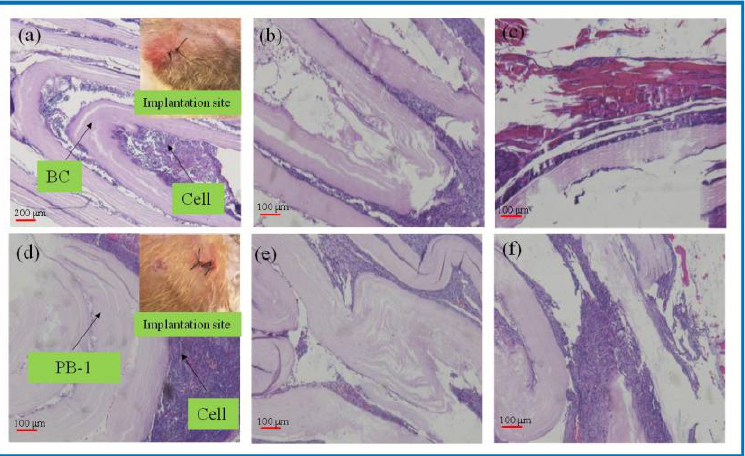
Figure 7. H&E-stained tissue sections embedded in vivo. ( a – c ): BC membrane implantation for 1 – 3 weeks; ( d – f ): PLA/BC-1 scaffold implantation for 1 – 2 weeks. 1–3 weeks; ( d – f ): PLA/BC-1 scaffold implantation for 1–2